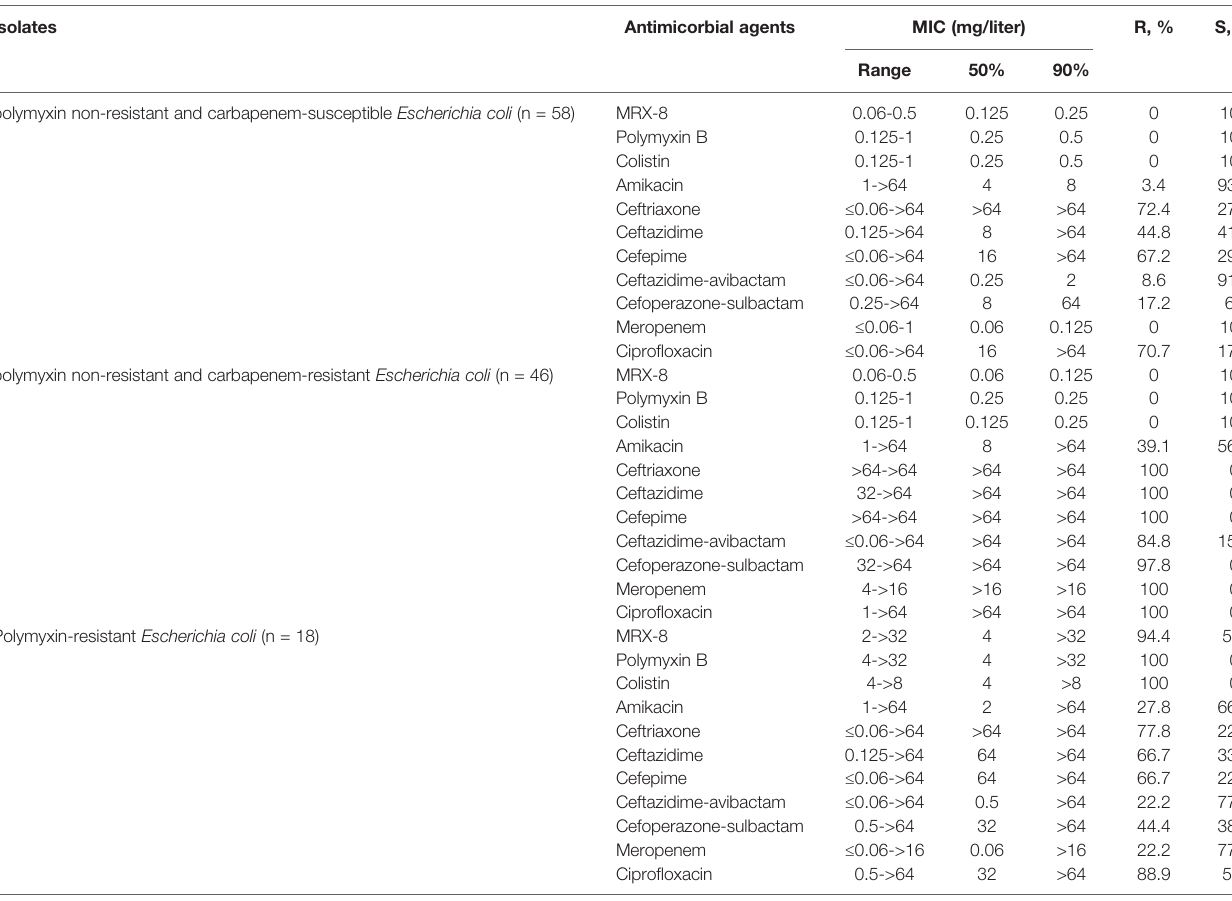
TABLE 1 | In vitro activity of MRX-8 and other comparator agents against 122 of Escherichia coli (mg/L). Isolates Antimicorbial agents MIC (mg/liter) R, % S, %